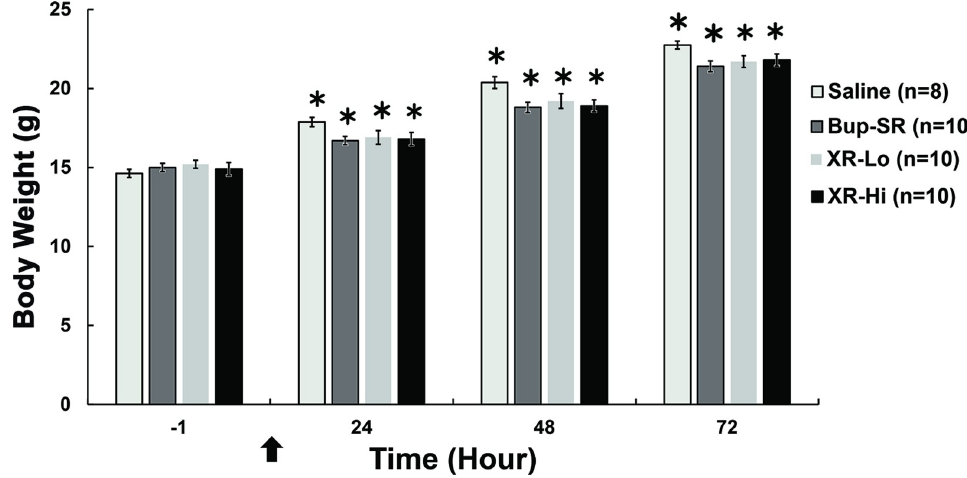
Fig 1. Body weights of rat pups throughout the course of the study. Mean body weight ± SEM. Arrow indicates the time of surgery. � Value significantly ( P < 0.05) increased compared to -1 h